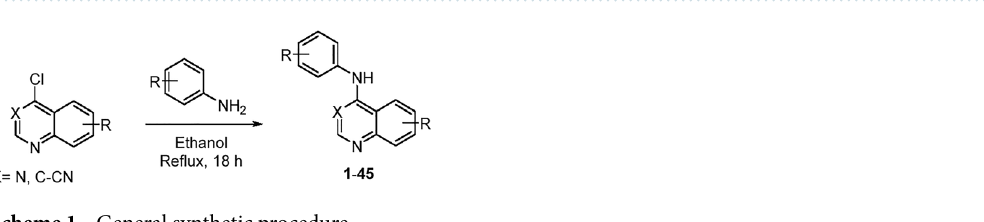
Figure 1. Previously reported inhibitors of chordoma and